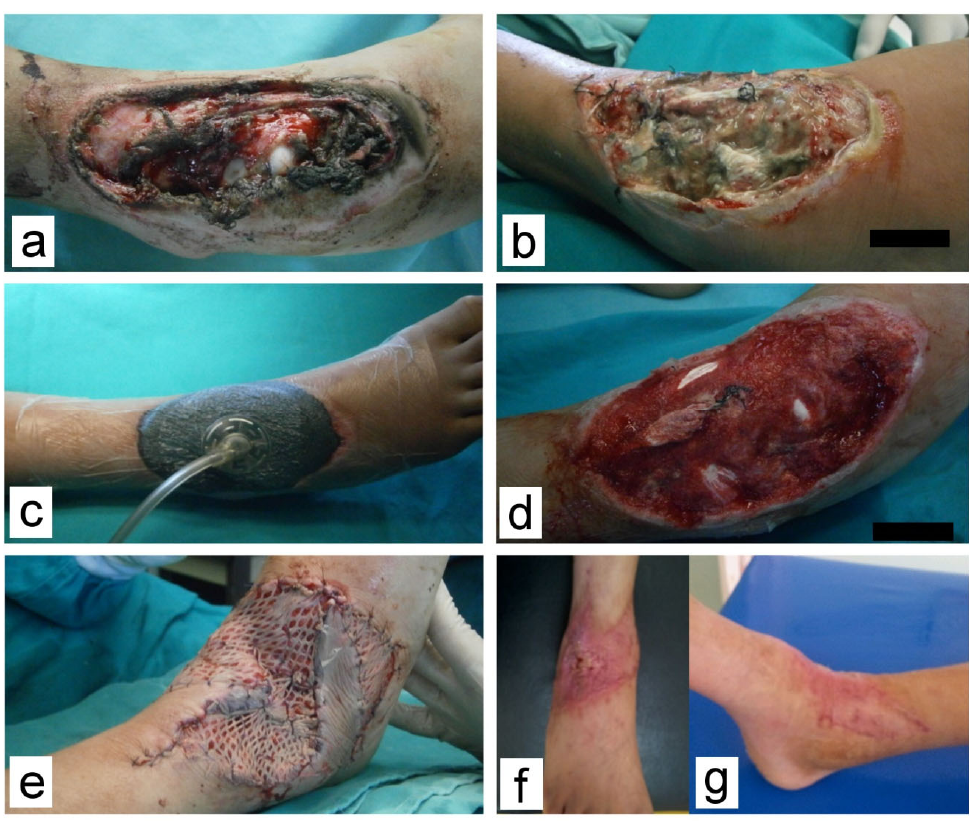
Table 4. Modality of definitive wound closure.